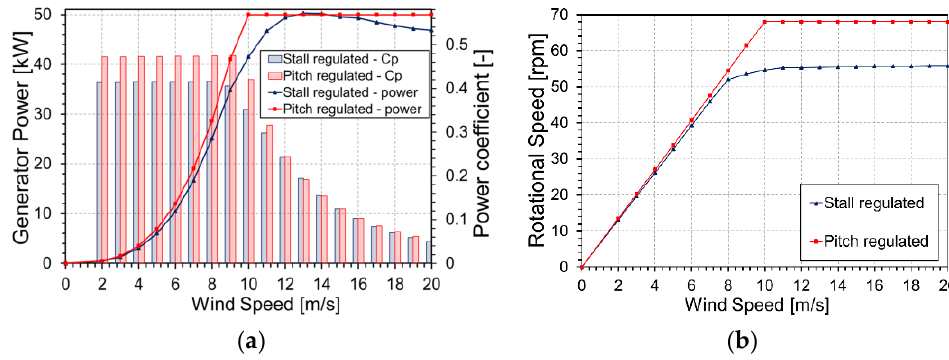
Figure 8. ( a ) Generator power and aerodynamic power coefficient; ( b ) rotational speed for pitch- and stall-regulated rotors in steady-state condition.